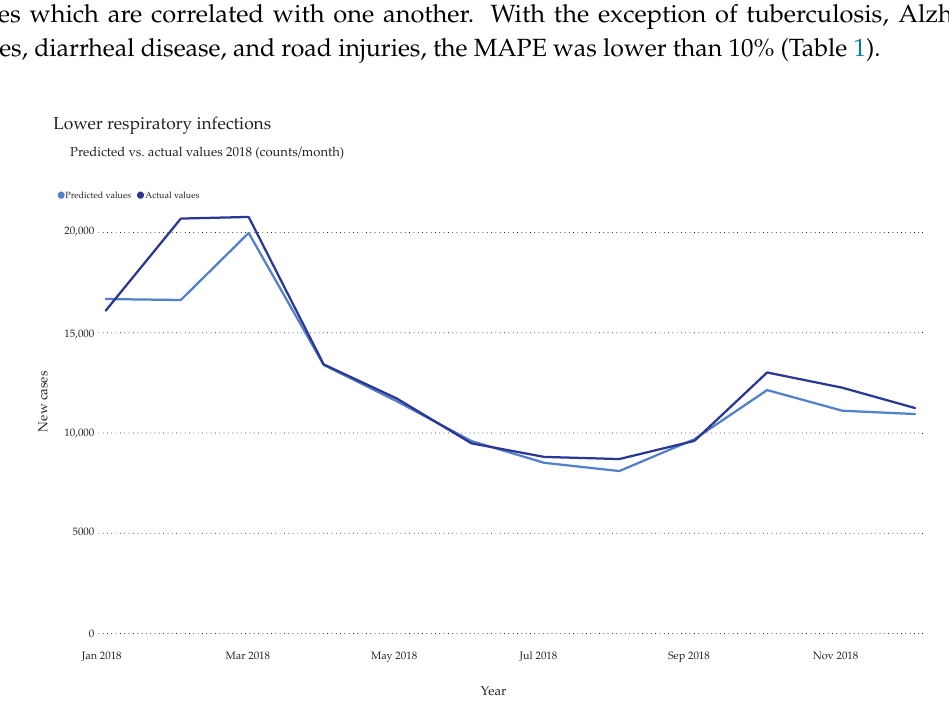
Figure 3. Holdout validation. Exemplary comparison between predicted total cases of lower respiratory infections and actual total cases extracted from the data set. The year 2018 was selected as holdout to test the model performance. All hospitalized lower respiratory infections cases in Romania (actual values) were plotted on a monthly basis against the predicted values calculated by the AVG Blender model (predicted